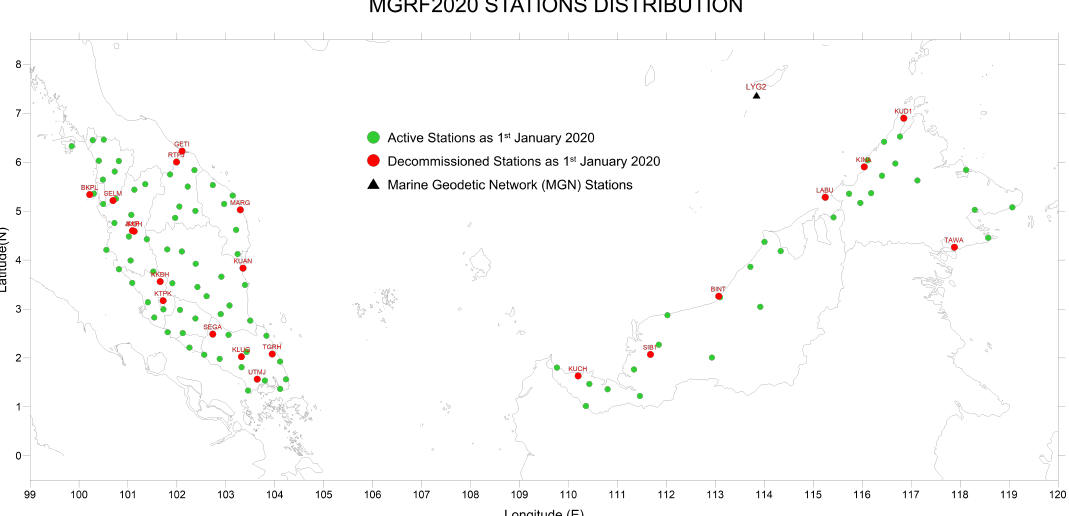
Fig. 4. Distribution of the Malaysian CORS included in the processing (green circle = active station; red circle = decommissioned station as 1 st January 2020; blue triangle =marine geodetic network station)